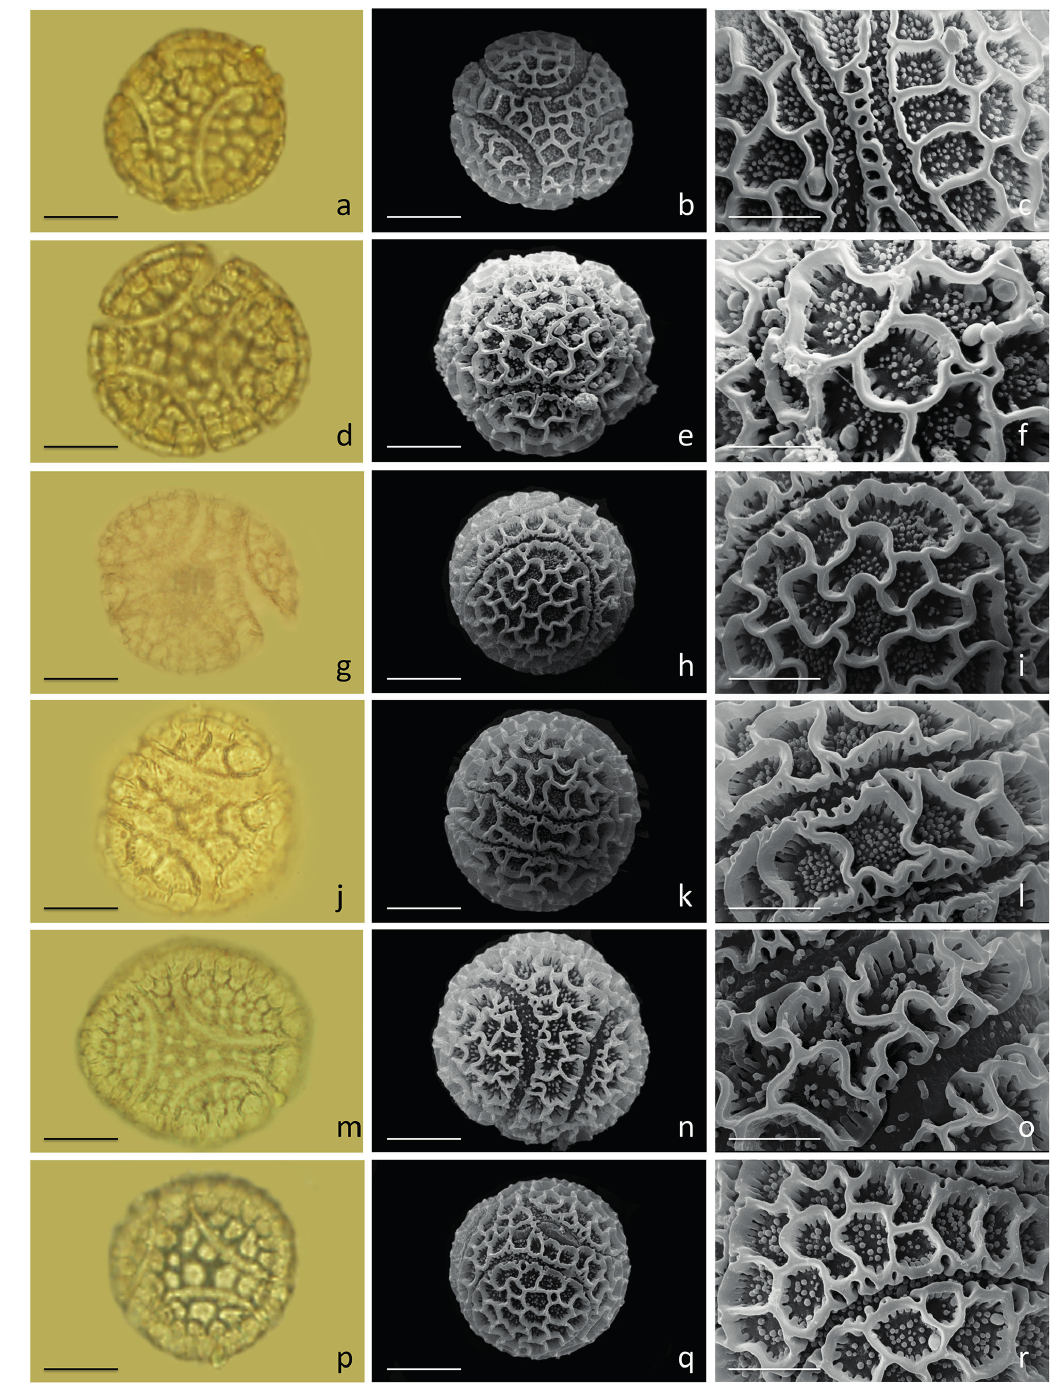
Figure 4 - Pollen grains of Passiflora using a light microscope (LM) and a scanning electron microscope (SEM); a-c ) P. setacea (BGP-237); d-f ) P. cincinnata (BGP-312); g-i ) P. racemosa (BGP-172); j-l ) P. mallacophyla (BGP- 170); m-o ) P. tenuifila (BGP-105) p-r ); P. edmundoi (BGP-046); a, d, g, j, m, p) LM overview; b, e, h, k, n, q) SEM overview; c, f, i, l, o, r) details of the exine and colpi using an SEM. Bars: a, b, d, e, g, h, j, k, m, n, p, q = 20 μm; c, f, i, l, o, r = 10